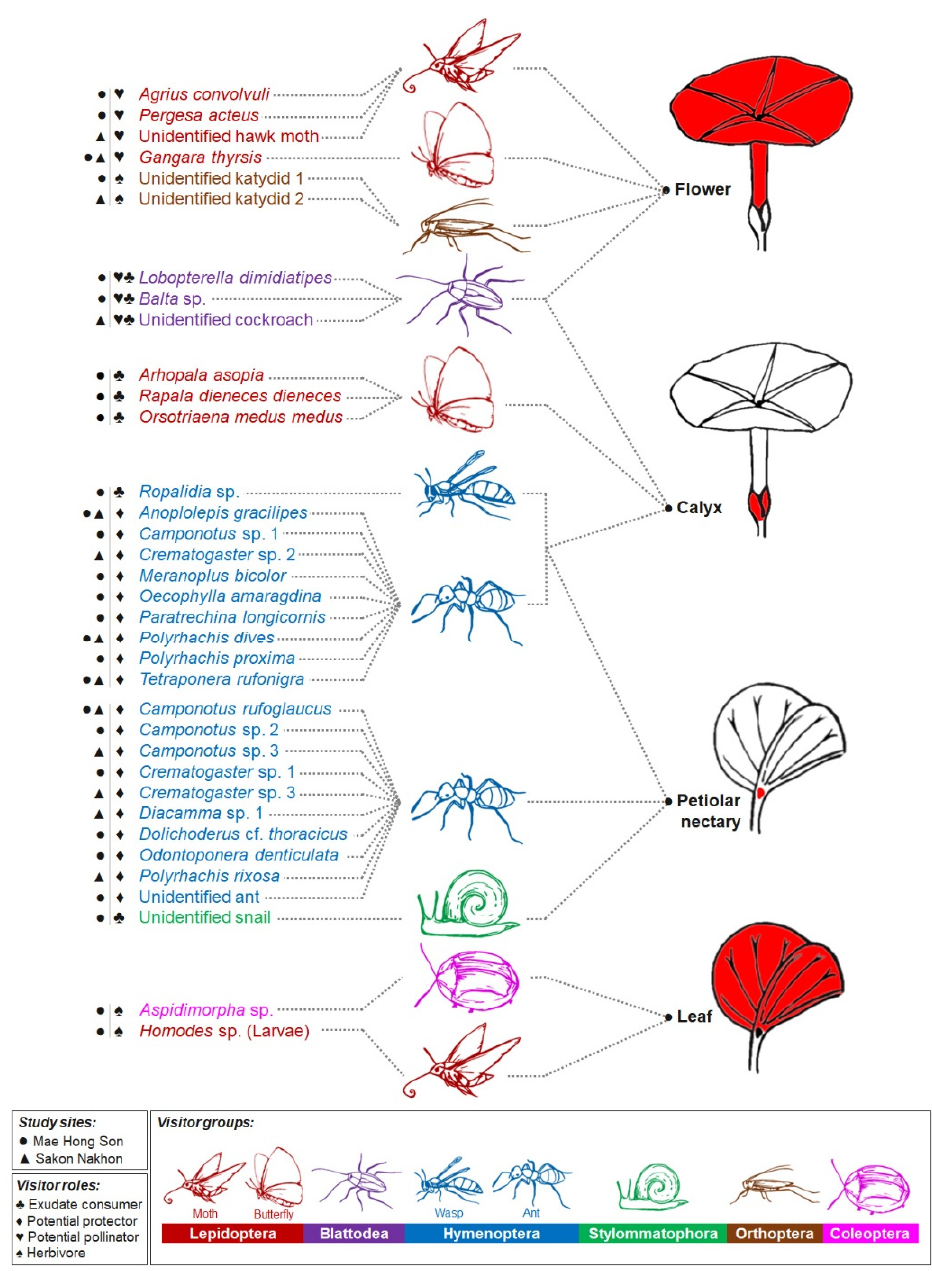
Figure 10. Diagram of animal visitors observed visiting plant parts where the studied external secretory structures are found (nectary disc and staminal hairs at flowers, calycinal glands at calyxes, petiolar nectaries at petioles, and foliar glands at leaves). Visitors were classified as: herbivore (consumes plant organs, such as leaves or flowers), potential protector (consumes exudates and may protect plant from herbivores), exudate consumer (consumes exudates but likely does not offer protection from herbivores), or potential pollinator (visits flowers and possibly pollinates them). Most visitors fell under a single category, with the exception of cockroaches (Blattodea), which were classified as both exudate consumers and potential pollinators. Note: Dashed lines connecting visitor names to plant parts only indicate that visits were observed, they do not indicate visitation fre- quency.